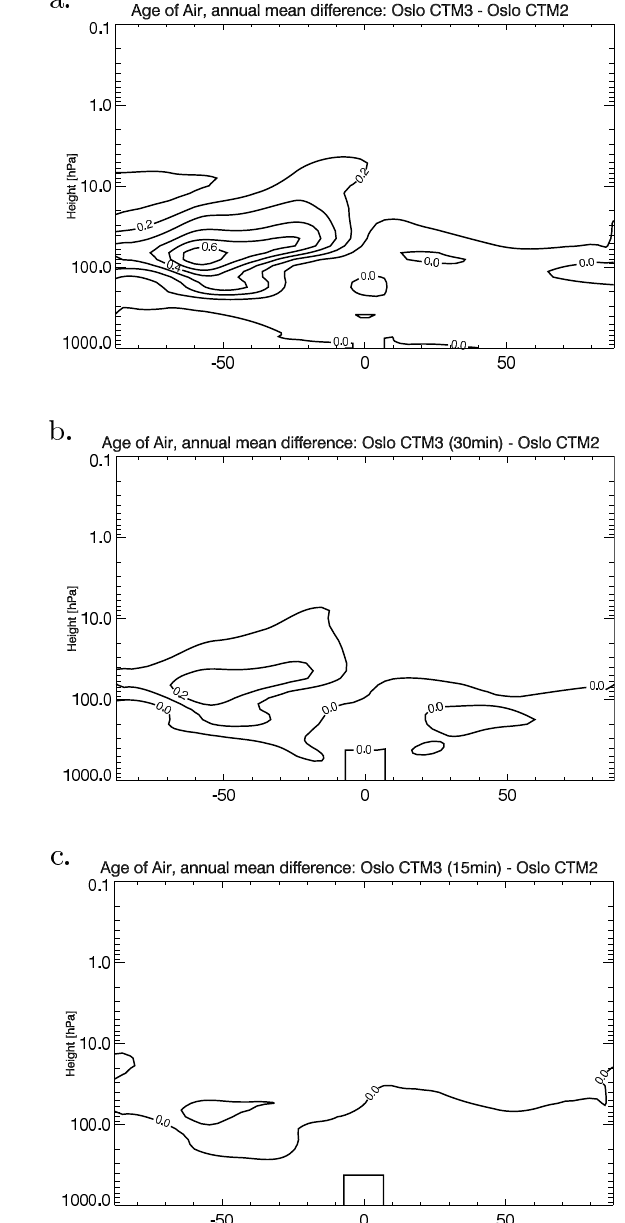
Fig. 2. Annual zonal mean age of air based on a tropical source tracer increasing linearly with time, after 20yr of transport, reso- lution T42L60. (a) CTM3, (b) CTM2 and (c) CTM3 with 30min operator-split time step.